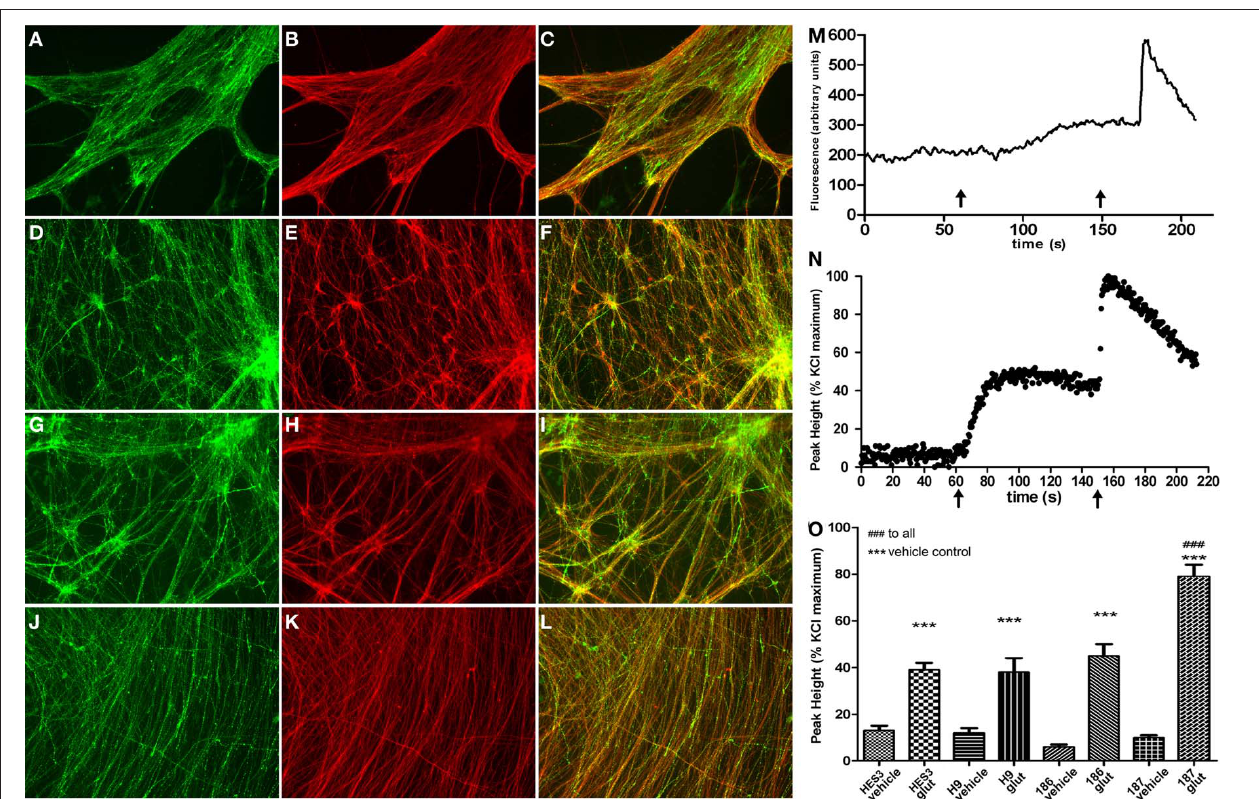
images illustrating co-localization between GABA and β -III-TUBULIN. (M) Example of a typical raw trace after background subtraction measured in arbitrary units of fluorescence intensity and (N) a typical neuronal Ca 2 + response profile, left x -axis arrows indicate glutamate (30 μ M) addition and right x -axis arrows KCl (30mM) addition. (O) Intracellular [Ca 2 + ] i levels in response to vehicle and glutamate (30 μ M) addition for all control and HD neuronal